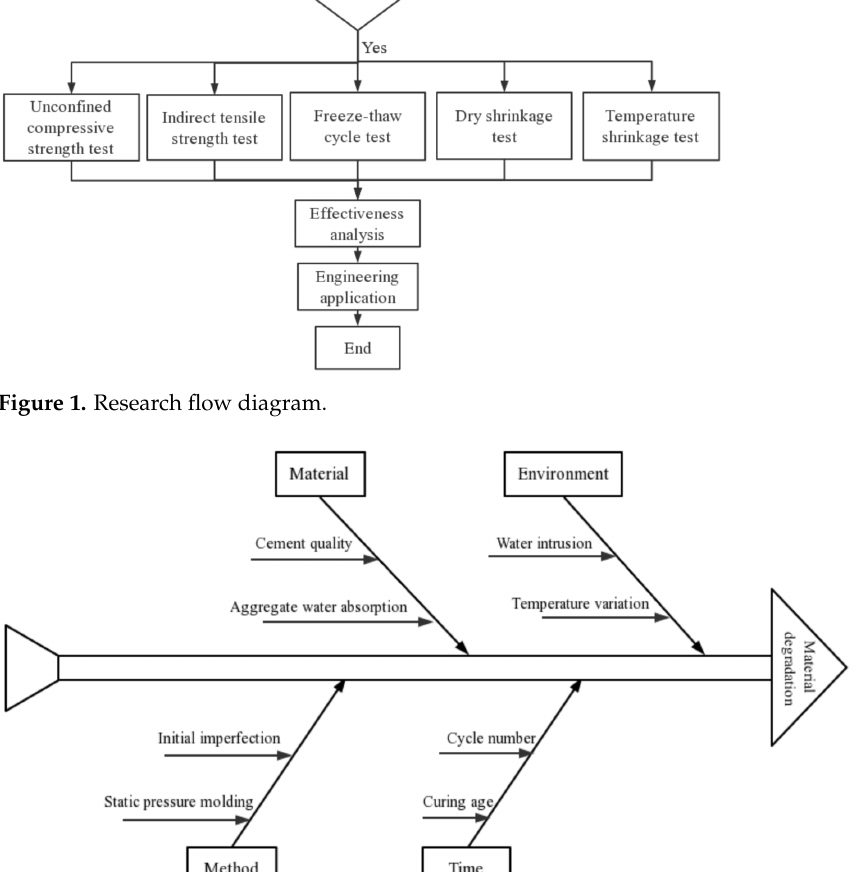
Figure 2. Ishikawa diagram that contains the cause of material degradation during freezing and